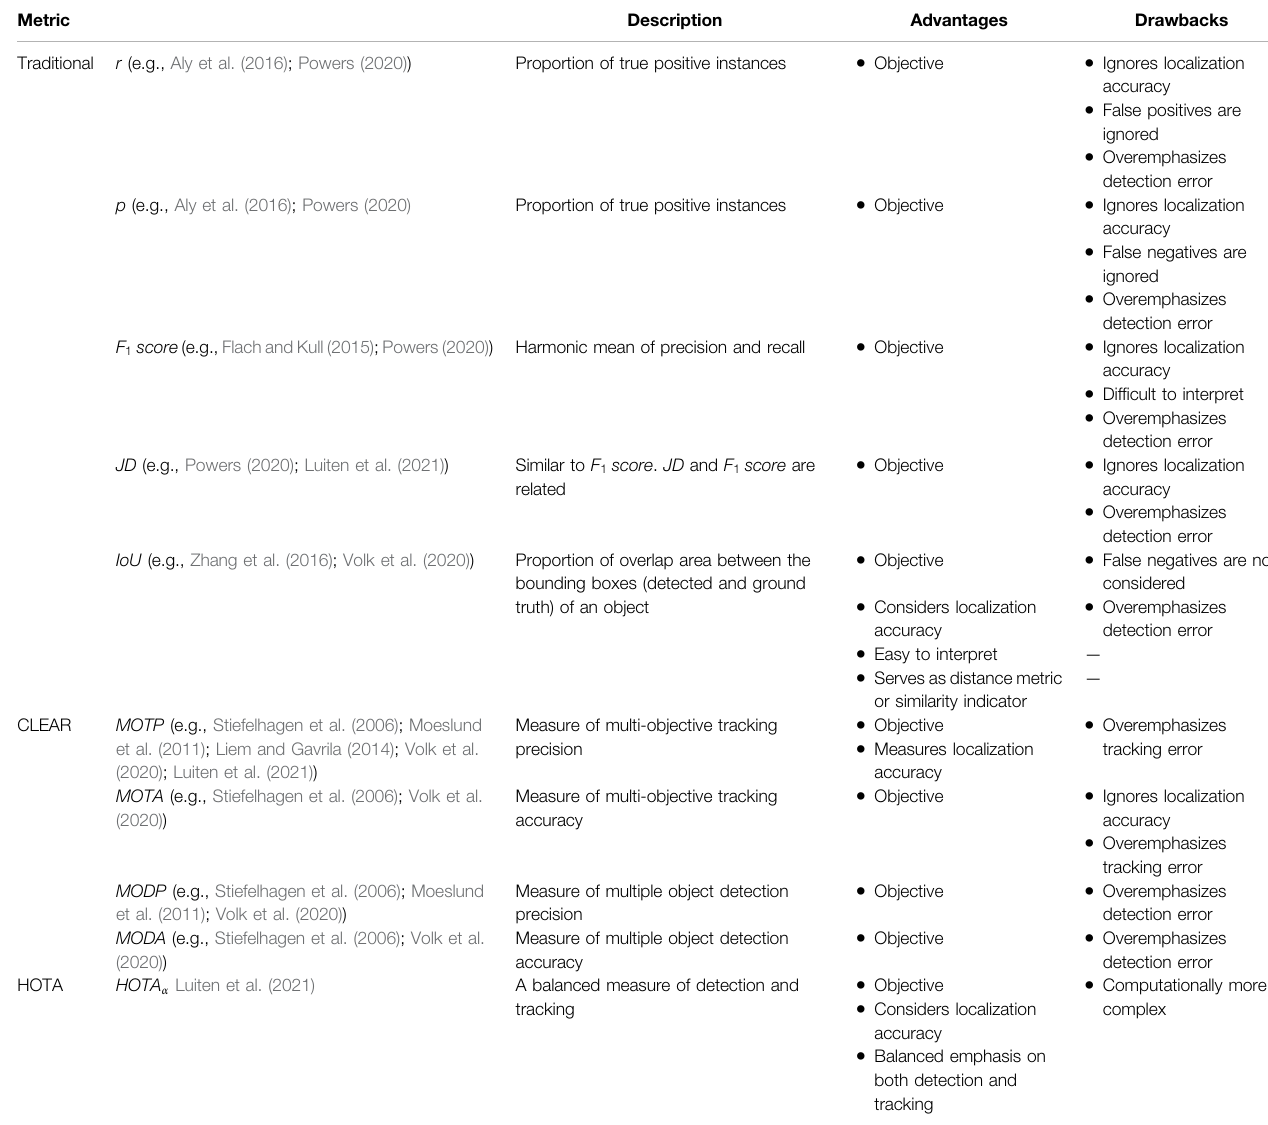
TABLE 2 | Metrics for environment